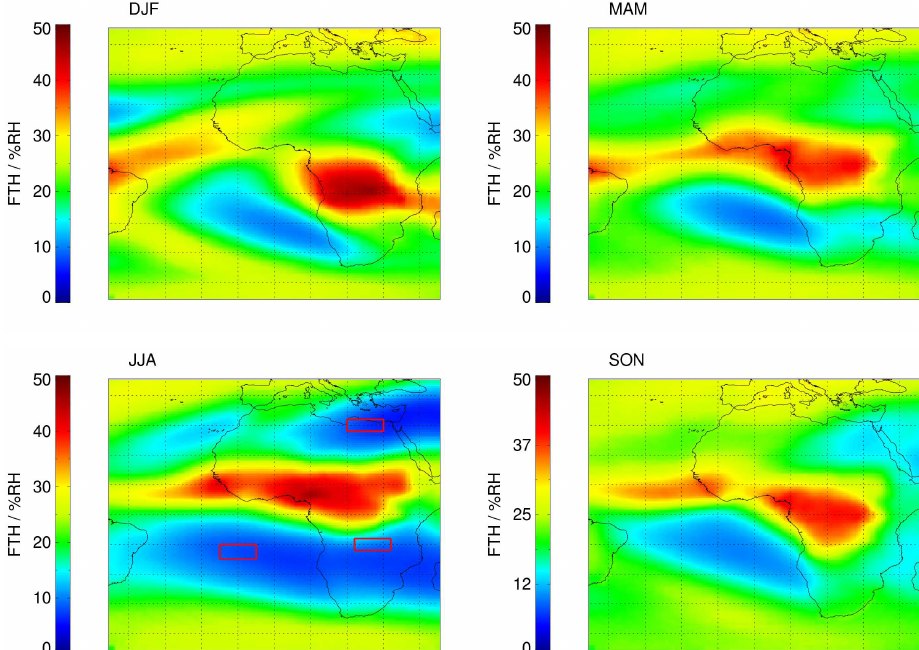
Figure 4. FTH seasonal averages: December-January-February (DJF, top left), March-April-May (MAM, top right), June-July-August (JJA, bottom left) and September-October-November (SON, bottom right). The period considered is 1984–2009. The red boxes indicate regions for which the average time series is plotted in Fig. 5.